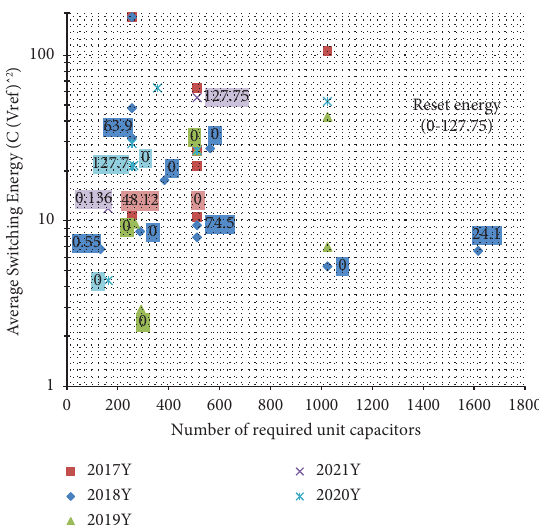
Figure 40: Te energy-efcient of a single SAR ADC